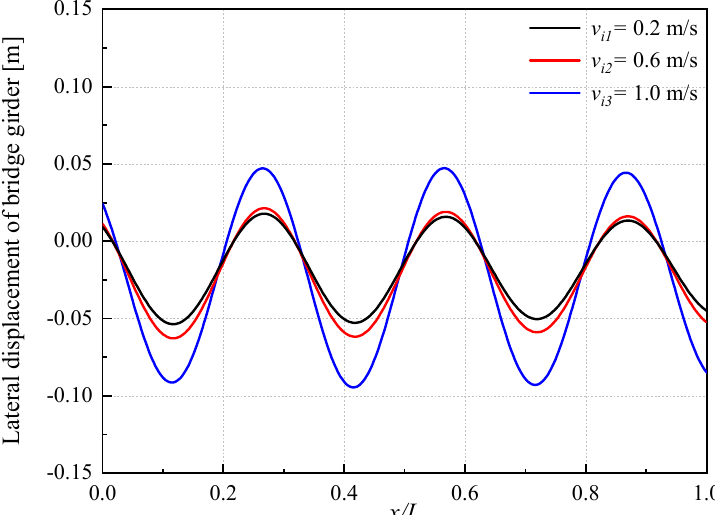
Figure 13. Lateral displacement of bridge girder under various ice velocities.